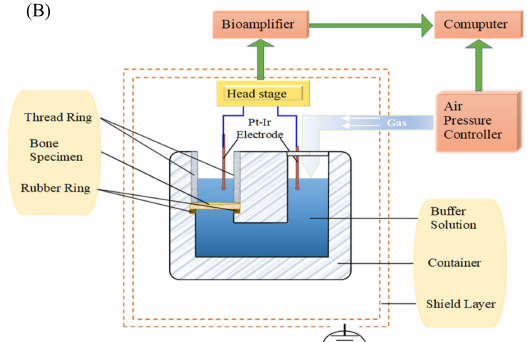
Figure 1. ( A ) Specimen and its location in the diaphysis of bovine tibias. ( B ) Schematic diagram of measurement